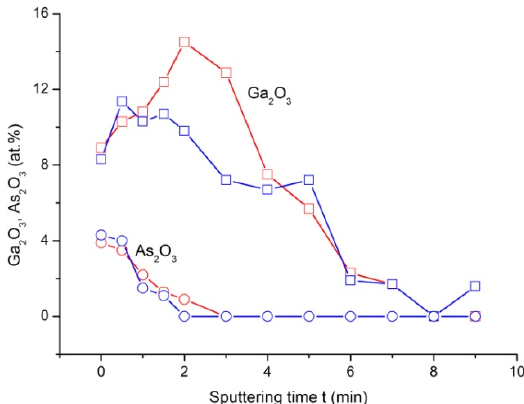
Figure 8. Dependences of the content of oxide components Ga 2 O 3 (square symbols) and As 2 O 3 (round symbols) in GaAs oxide on sputtering time: blue (symbols and lines)—for unmodified GaAs surface; red (symbols and lines)—for modified area.